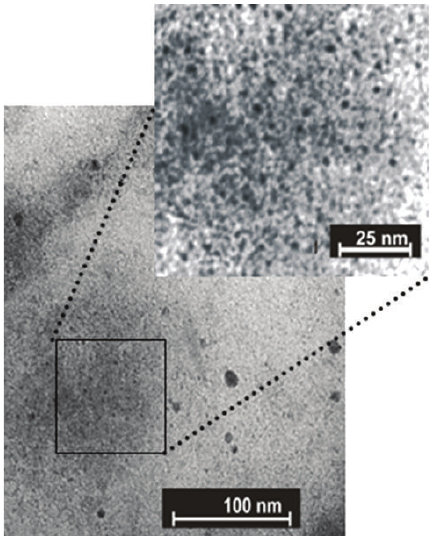
Figure 7: TEM images of the samples annealed during 48 h at 420 ∘ C [2].